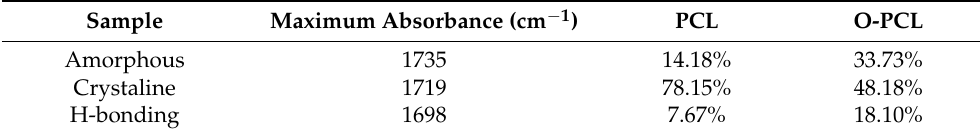
Table 1. Normalized intensity of the deconvoluted carboxyl absorption band.